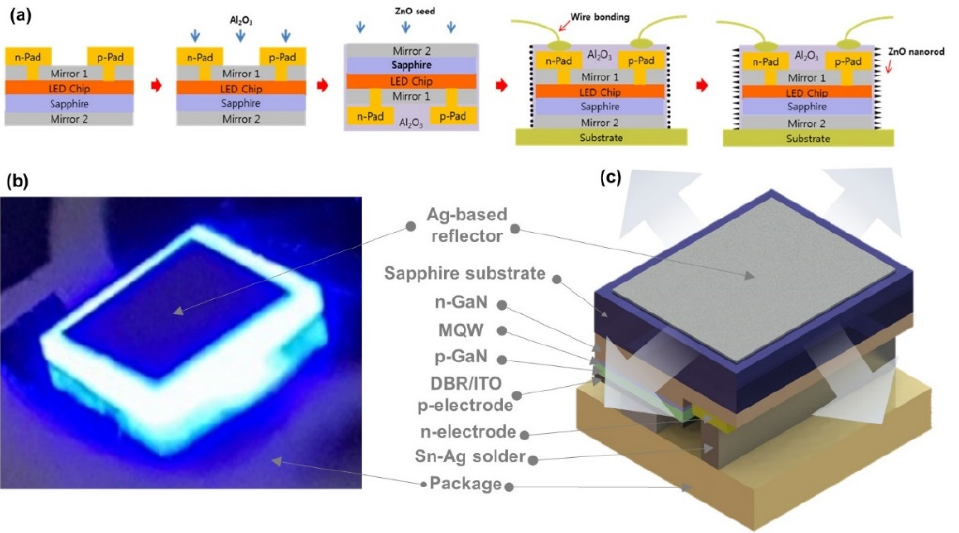
Figure 1. ( a ) The schematic fabrication process flowchart of a USE-LED. ( b ) Light emission from the sidewalls. ( c ) Detailed description of a flip-chip USE-LED.